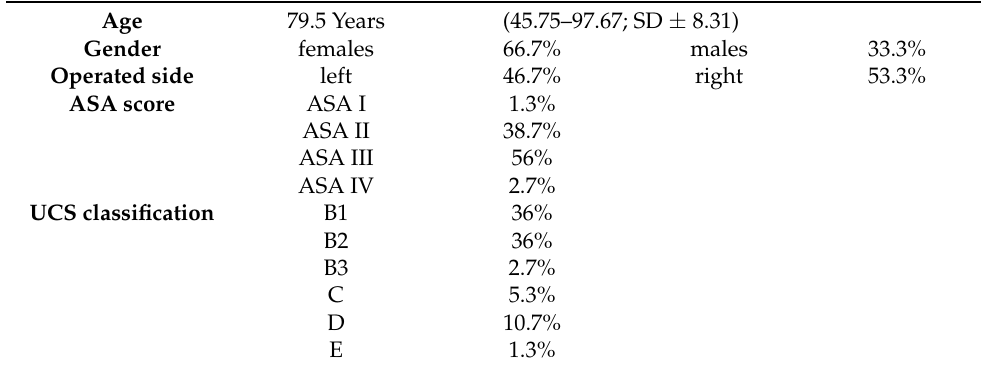
Figure 2. An overview of the patient cohort, their general condition and the periprosthetic fracture classification. ( A ) Gender of patients, ( B ) site of injury, ( C , D ) frequency and severity of CCI score among patients. ( E ) UCS classification. Table 1. General patient population.